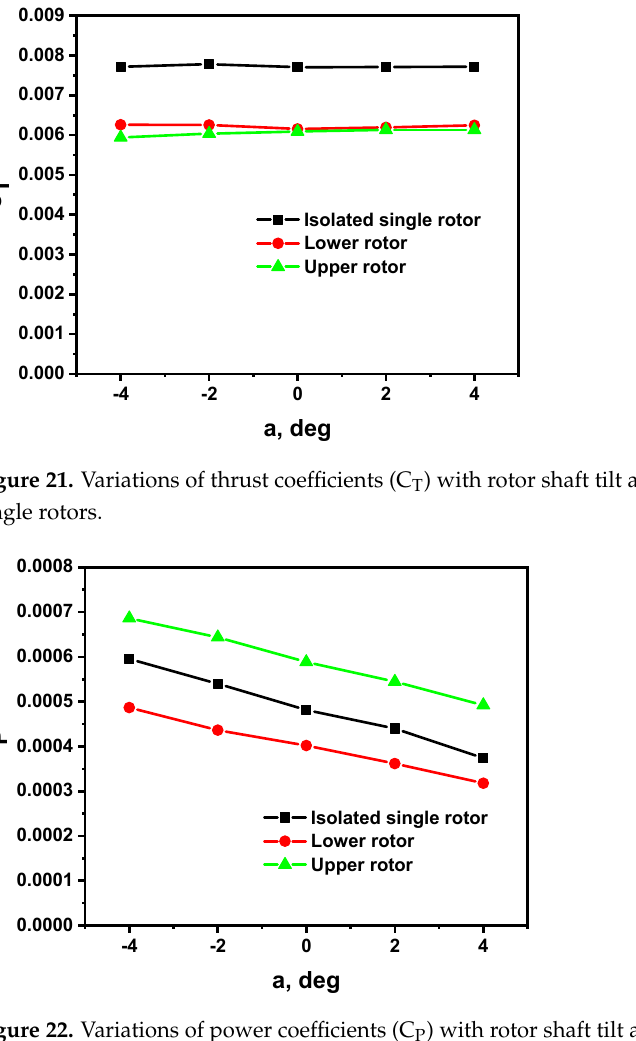
Figure 22. Variations of power coefficients (C P ) with rotor shaft tilt angles (a) for coaxial and isolated single rotors.